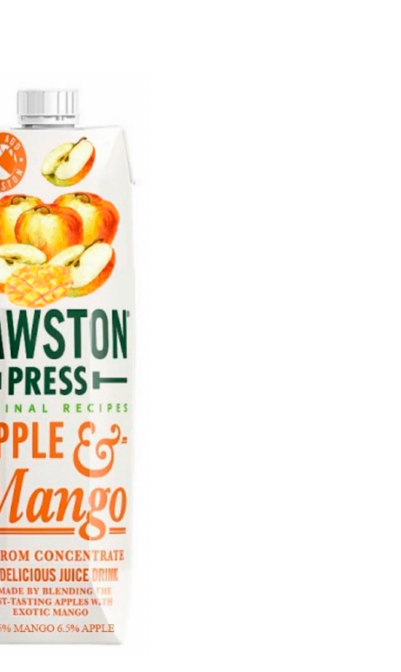
Figure 4. Example of one of the combinations of the packaging including the ingredient list as used in Study